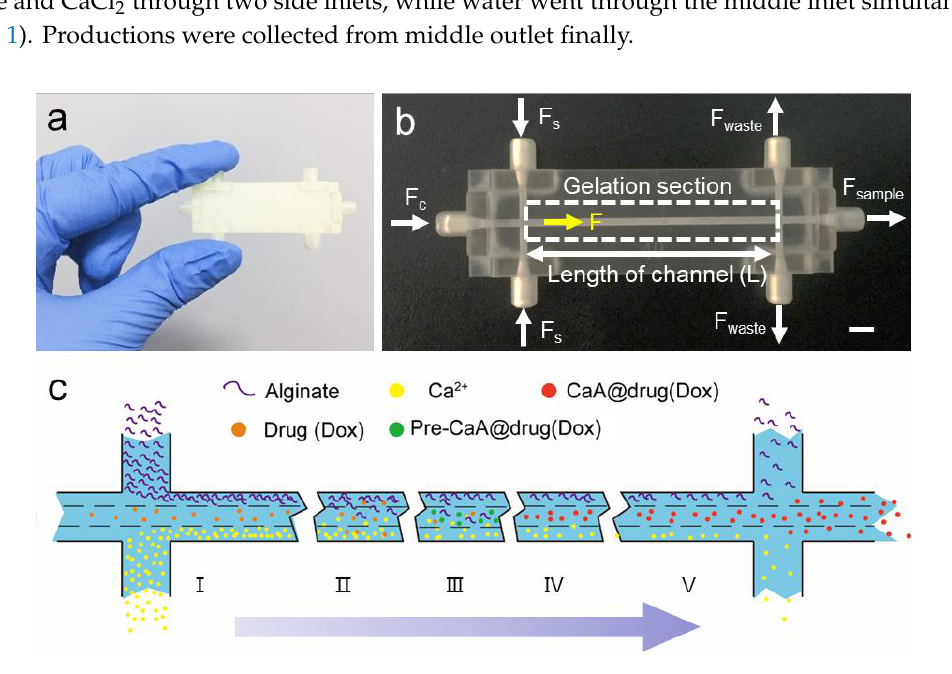
Figure 1. 3D-printed concentration-controlled microfluidic chip for the synthesis of CaA microgels and the diffusion mixing pattern. ( a ) Photograph of the 3D-printed concentration-controlled microfluidic chip. ( b ) Photograph of the 3D-printed concentration-controlled microfluidic chip of 30 mm. The F c represents the middle stream flow rate. F s represents the side stream flow rate.